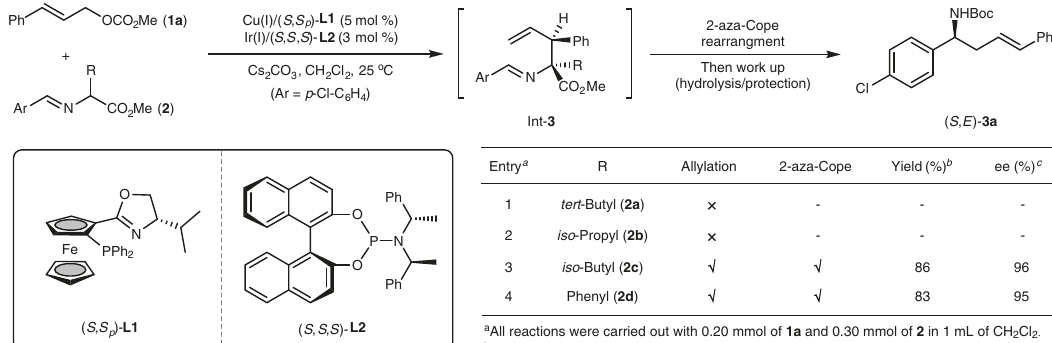
Fig. 2 Steric effect in this reaction. Initial test to fi nd an aldimine ester bearing an appropriate α -substituent to facilitate both allylation and